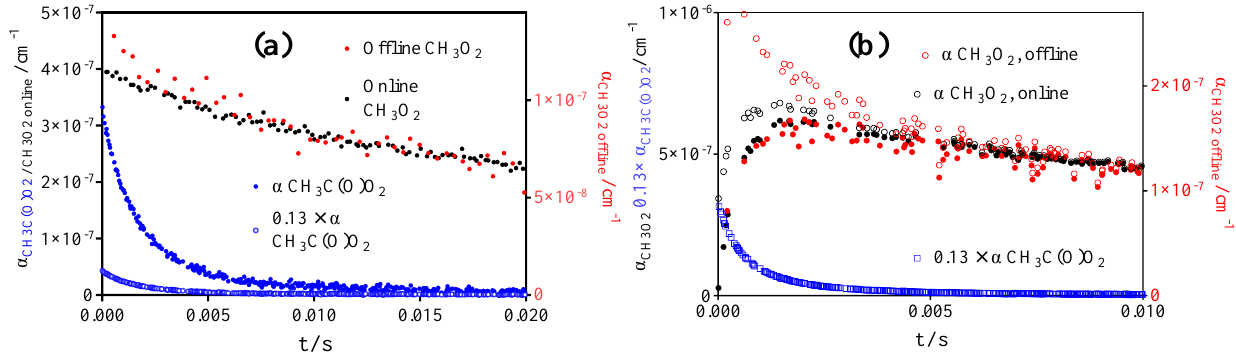
Figure 4. ( a ) Kinetic decays following the 248 nm photolysis of [CH 3 C(O)CH 3 ] = 9.8 × 10 15 cm − 3 at 200 Torr. ( b ) Kinetic decays obtained following the 351 nm photolysis of [Cl 2 ] = 1.6 × 10 16 cm − 3 , [CH 3 CHO] = 5.9 × 10 15 cm − 3 . Black circles show online CH 3 O 2 • measurement (left y -axis), red circles are offline CH 3 O 2 • measurements (right y -axis). Blue circles show simultaneous CH 3 C(O)O 2 • measurements with open symbols after multiplication with 0.13 to match CH 3 O 2 • absorption (see text). Open and filled circles in ( b ) see text on Cl • + CH 3 C(O)H precursor